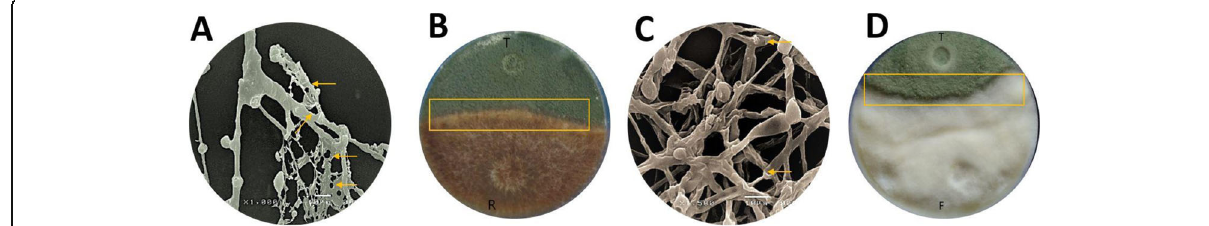
Fig. 2 Mycoparasitism of Trichoderma species: A SEM photomicrographs indicate the holes (yellow arrows) caused by the interaction between Trichoderma harzianum and root rot pathogen ( Rhizoctonia solani ) after 4 days of incubation, (magnification 500 ×: bar = 10 μ m). B Dual culture assay shows the T. harzianum interact with R. solani in vitro. C Hyphal interaction of Trichoderma asperellum and a root rot pathogen ( Fusarium solani ) after 5 days of incubation, yellow arrows show the coiling of hyphae (magnification 1000 ×: scale bar = 10 μ m). D Antagonism of